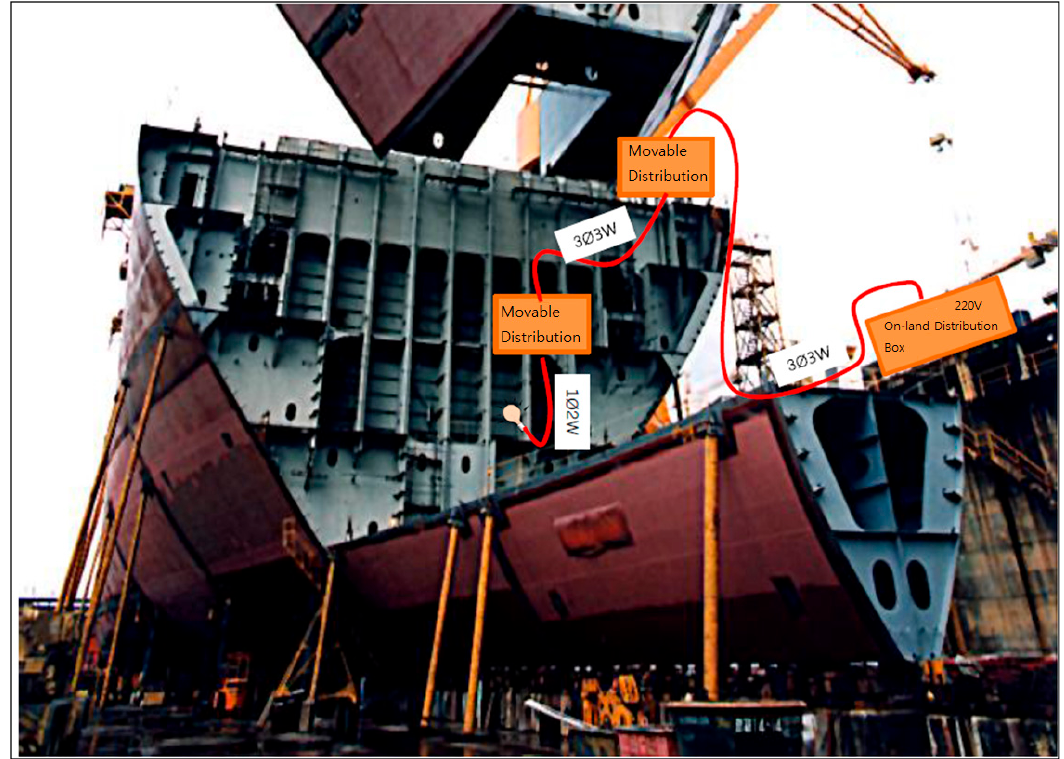
Figure 7. Shipbuilding at the shipyard.